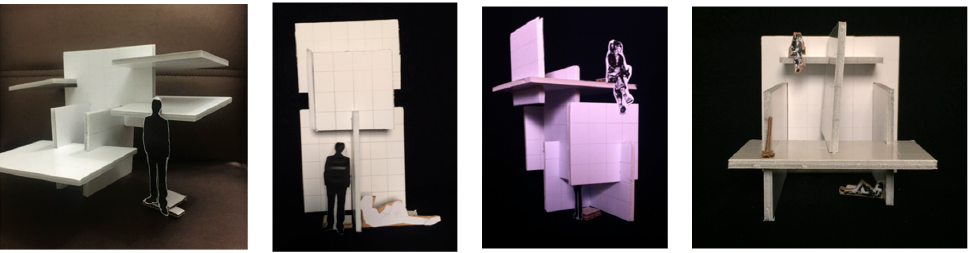
Figure 5. Examples of three ‐ dimensional exploration and space articulation via human scale.